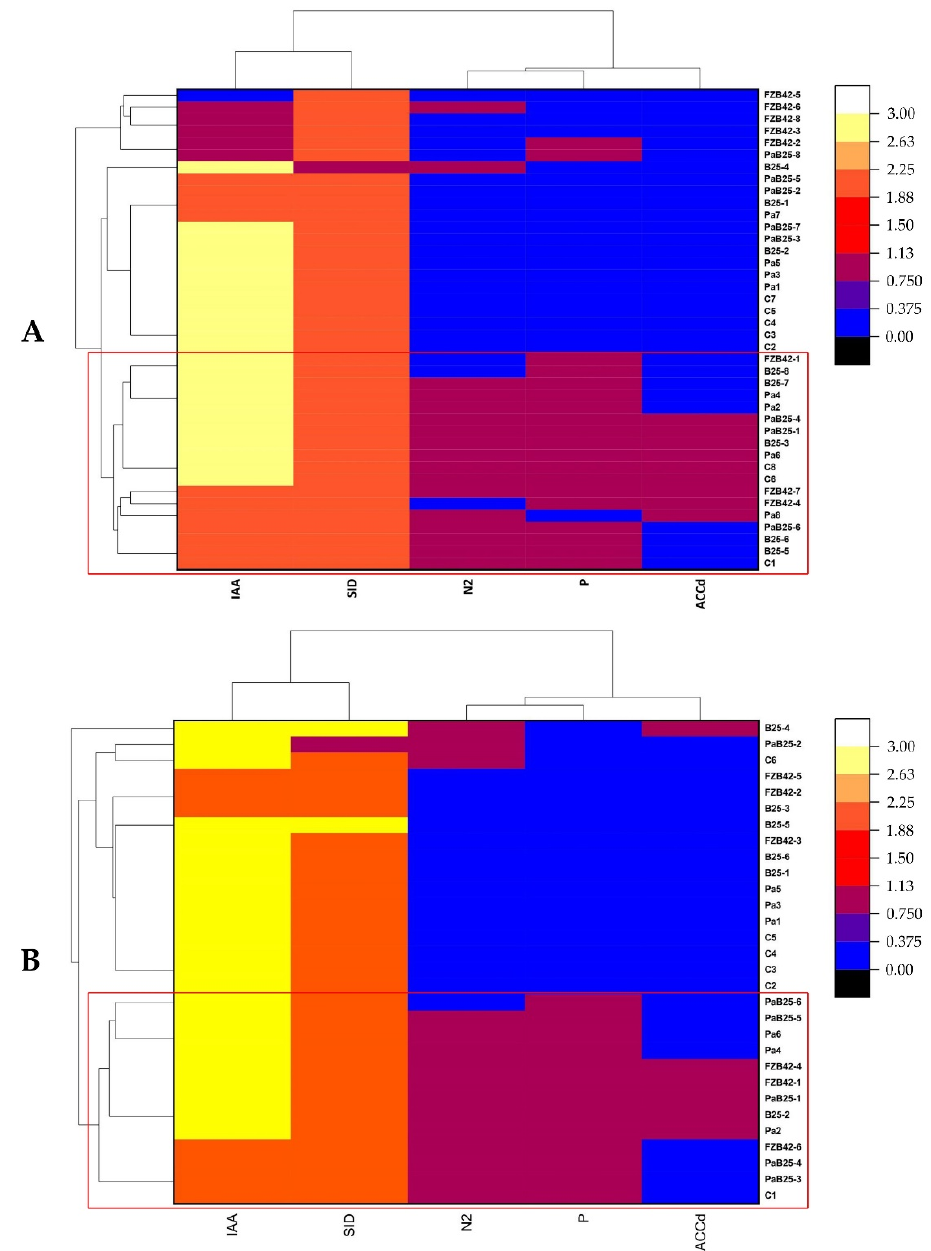
Figure 13. Clusters and heat map of endophytic bacteria from the durum wheat roots inoculated with Pa, B25, FZB42, and Pa + B25 and the expression of their PGP activities (IAA: indole acetic acid production, SID: siderophore production, N 2 : nitrogen fixation, P: phosphate solubilization, and ACCd: 1-aminocyclopropane-1-carboxylic acid deaminase production). ( A ) Bousselam variety; ( B